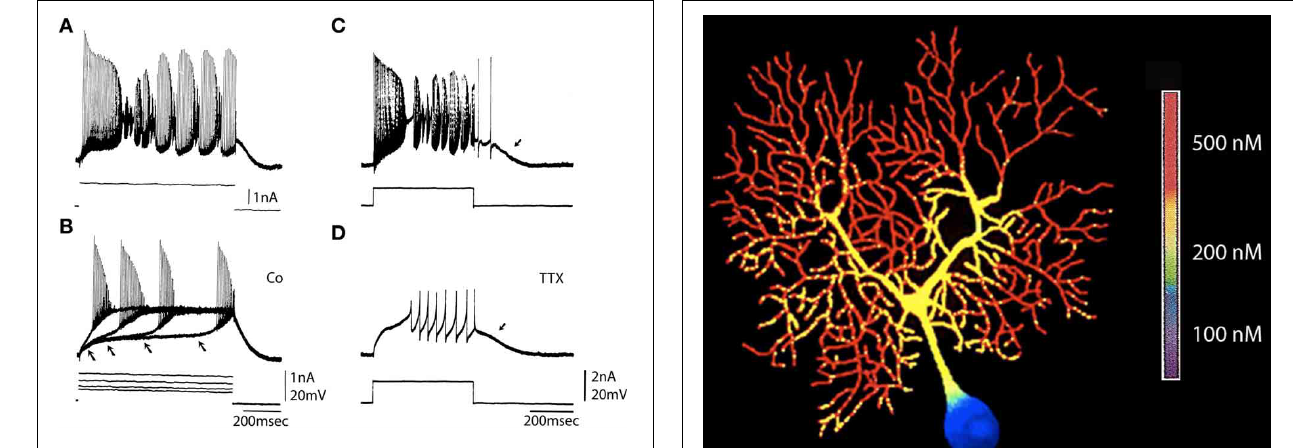
FIGURE 2 | Ionic basis for Purkinje somatic recordings. (A) Activity elicited from Purkinje cell soma by direct depolarization. Note fast spikes and underlying slower depolarizations. (B) After blocking the calcium conductance by addition of Co to the bath direct depolarization elicited fast spikes. Note that with increased depolarization spike onset moved to the left (arrows), but the plateau level of spike threshold did not change. (C) Repetitive response to somatic depolarization. (D) Block of sodium channels with TTX reveals underlying slow spikes and afterdepolarization (arrow). (From Llinás and Sugimori, 1980a.).